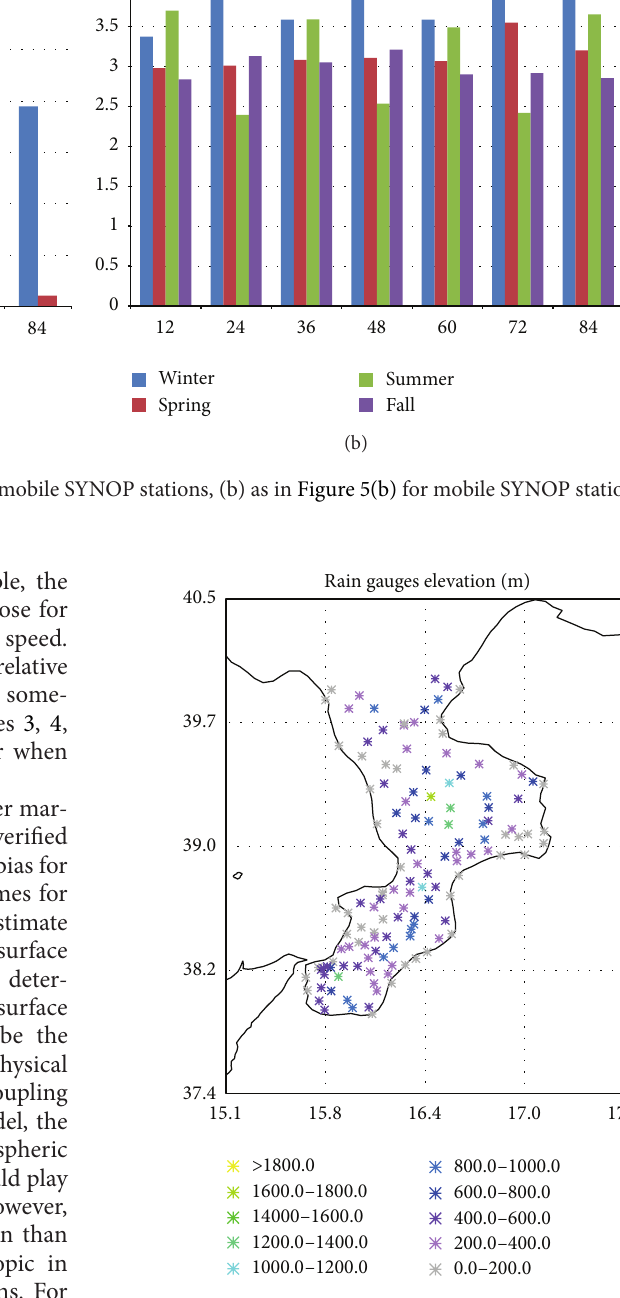
Figure 10: Rain gauges available for Calabria. The elevation above sea level of the stations is shown in different